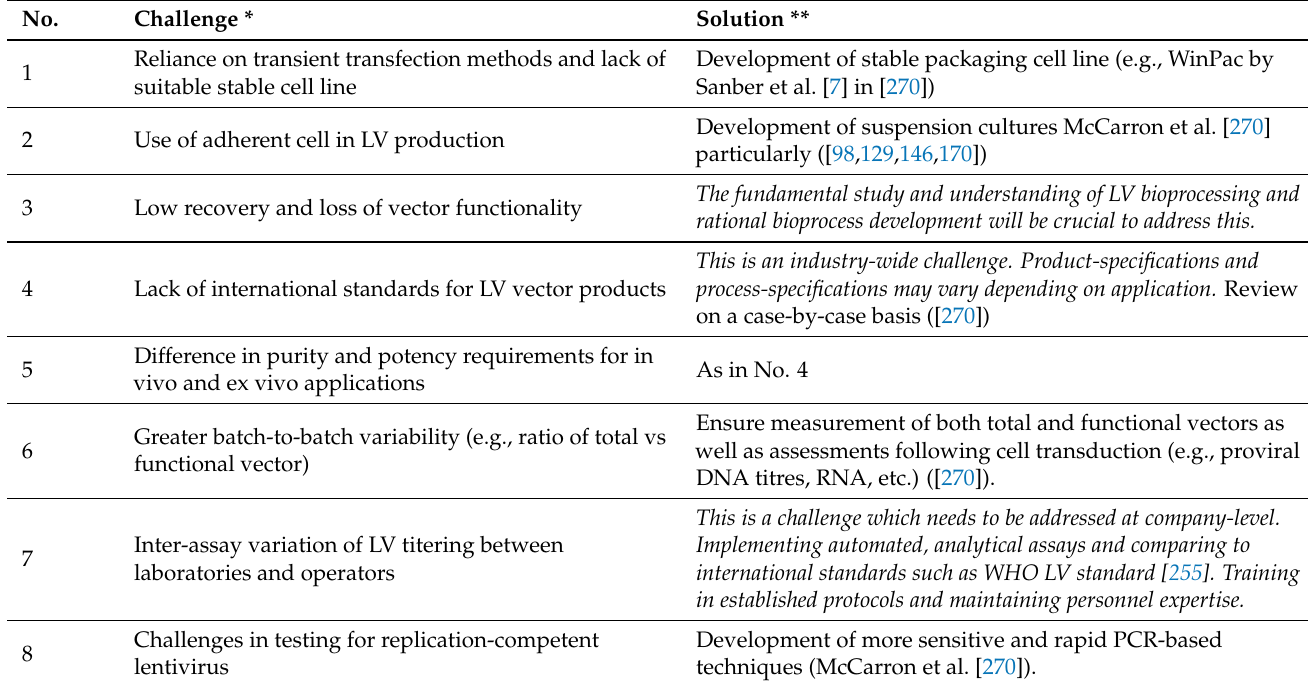
Table 9. Known challenges in LV